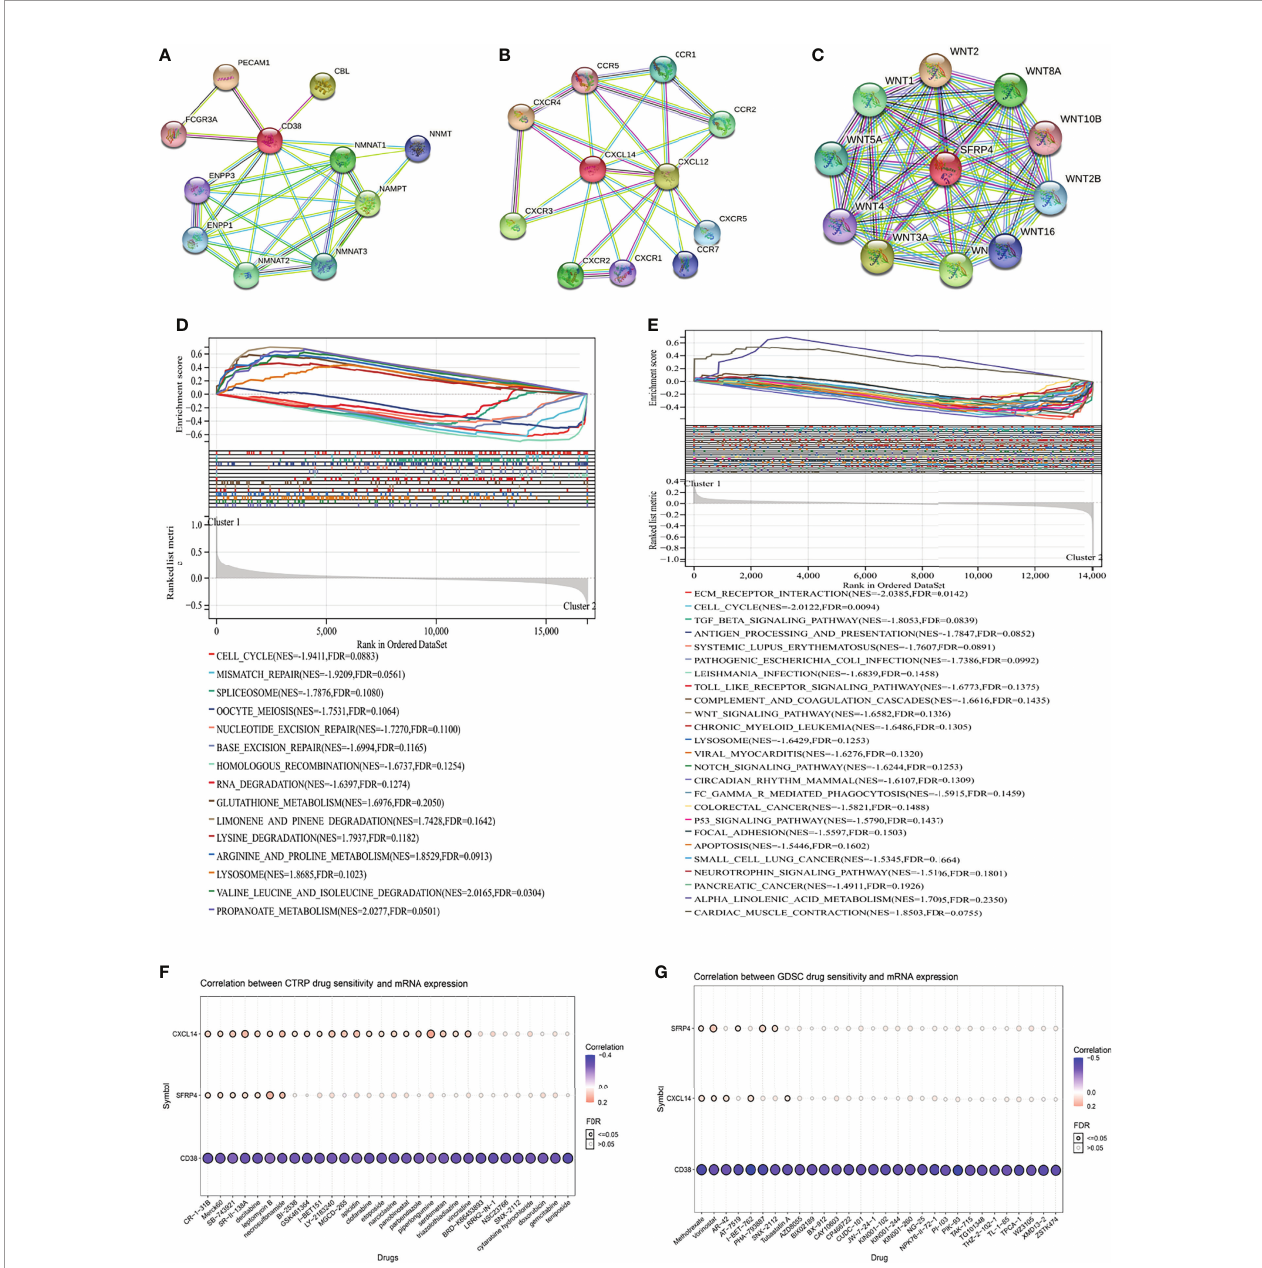
FIGURE 4 | Function and drug analysis. (A) predicted functional partners of CD38; (B) predicted functional partners of CXCL14; (C) predicted functional partners of SFRP4; (D) GSEA analysis of the two clusters in the TCGA database; (E) GSEA analysis of the two clusters in the GSE116918 (17); (F) correlation between CTRP drug sensitivity and mRNA expression of CXCL14, CD38, and SFRP4; (G) correlation between GDSC drug sensitivity and mRNA expression of CXCL14, CD38, and SFRP4. GSEA, gene set enrichment analysis; CTRP, cancer therapeutics response portal; GDSC, genomics of drug sensitivity in